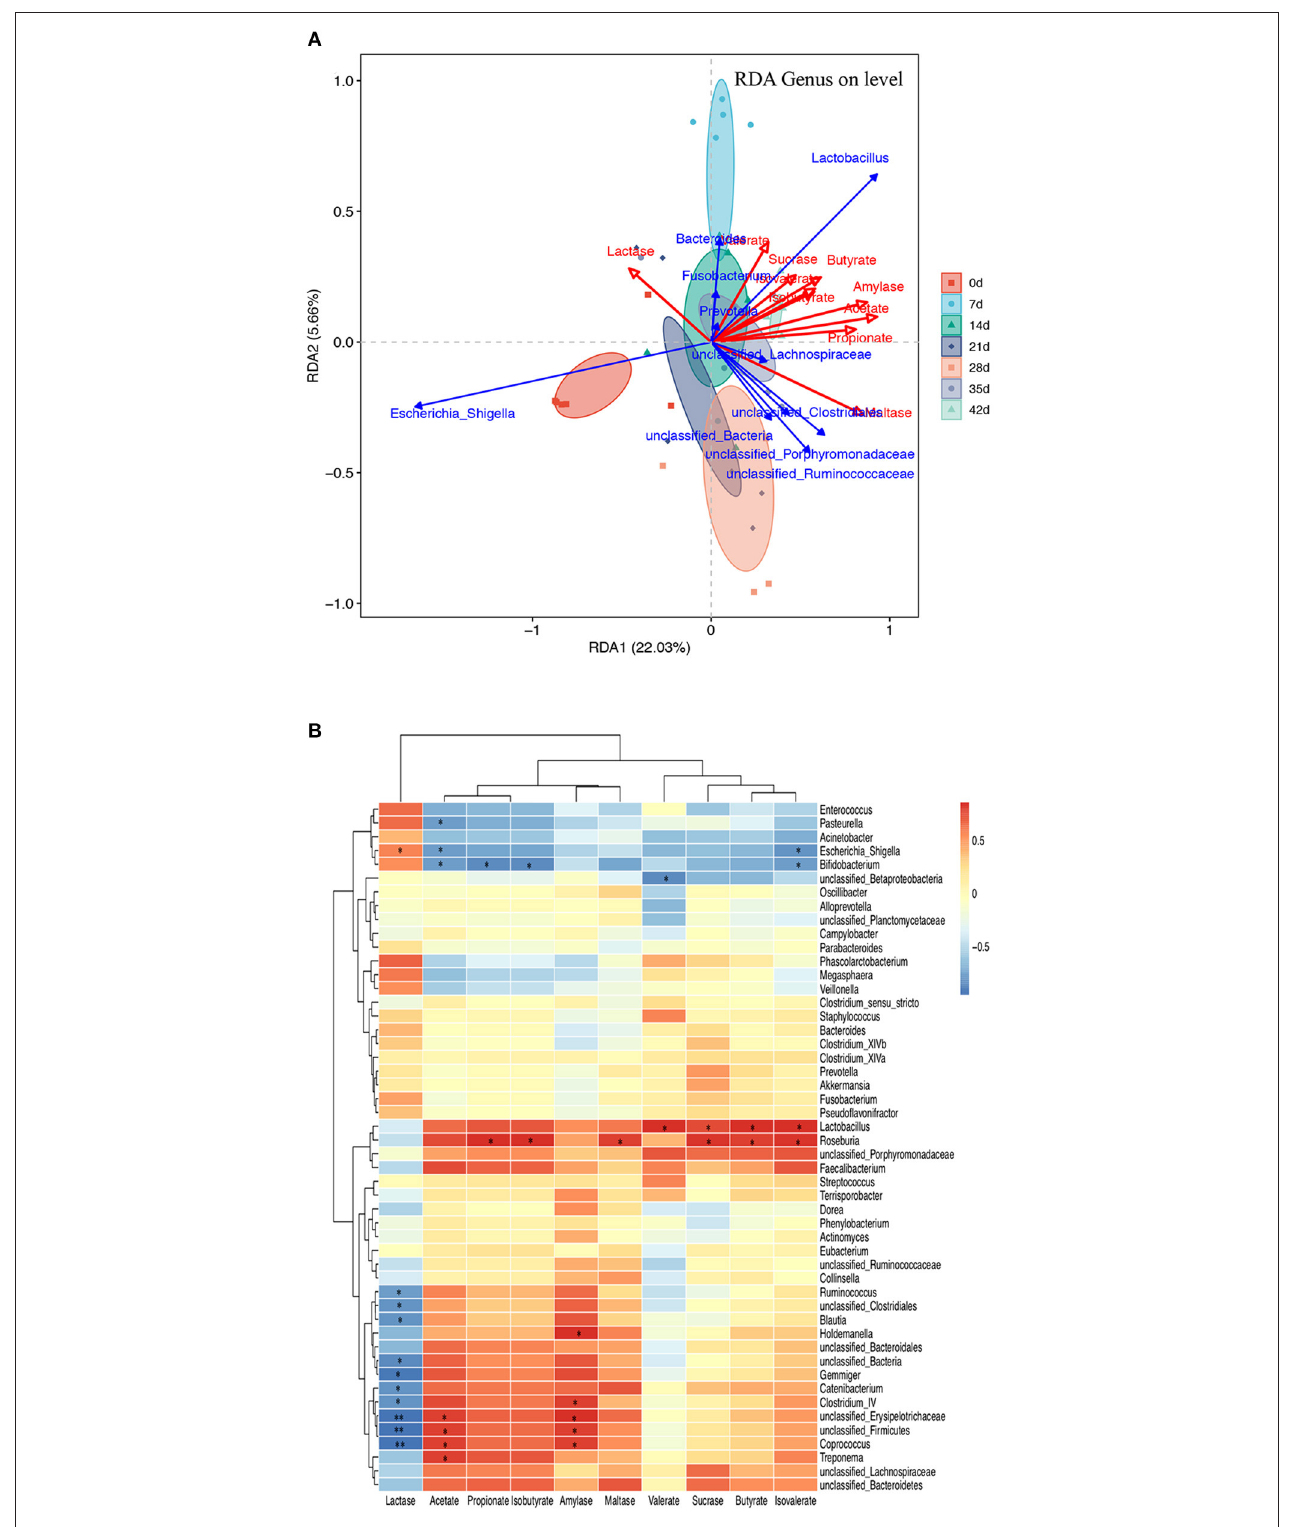
FIGURE 7 | Microbiota–metabolite correlation. (A) Triplot of RDA of the colonic microbial composition at genus level relative to pancreatic amylase, jejunal disaccharidase, and colonic SCFAs. The microbiota of different age groups are represented by different colors. Constrained explanatory variables (amylase, SCFA, and disaccharidase) are indicated by red arrows. Responding taxa are indicated by blue arrows, and only those with a higher fit in the ordination plot are labeled. The first (22.03% interpretation) and second coordinates (5.66% interpretation) are plotted. (B) A heatmap of the correlation analysis was conducted between the top 50 bacterial genera and the environmental factors. *0.01 < P ≤ 0.05 and **0.001 < P ≤ 0.01.